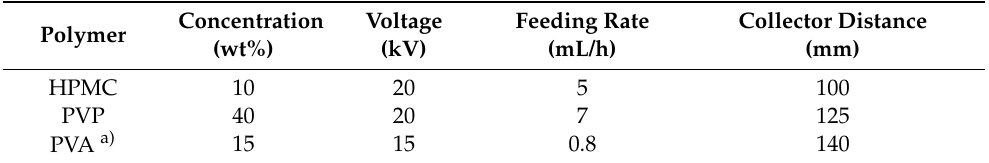
Table 1. Optimized technological parameters used for the electrospinning of fibers prepared from the polymers used in this study.